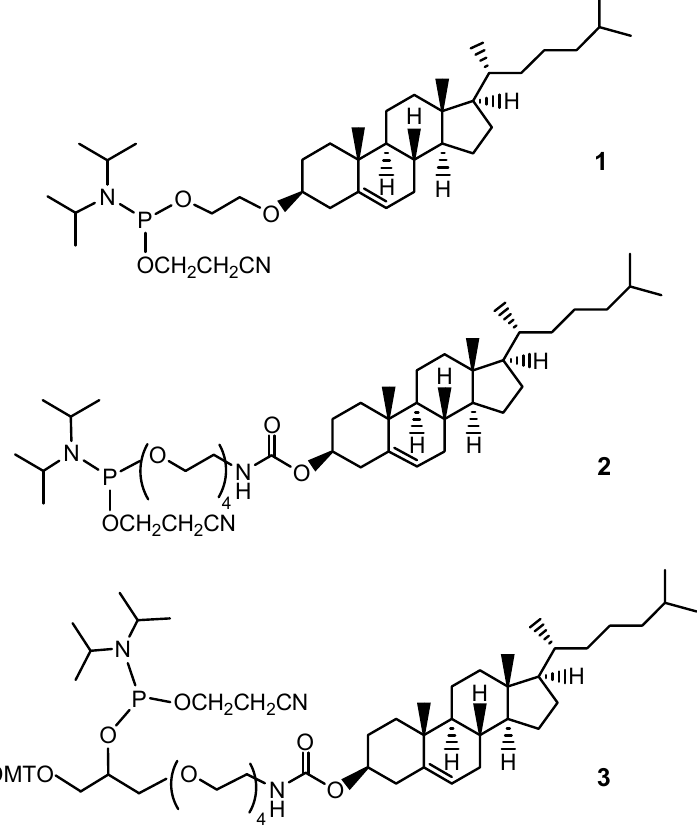
Figure 1. Chemical structures of known phosphoramidite derivatives of cholesterol 1 – 3